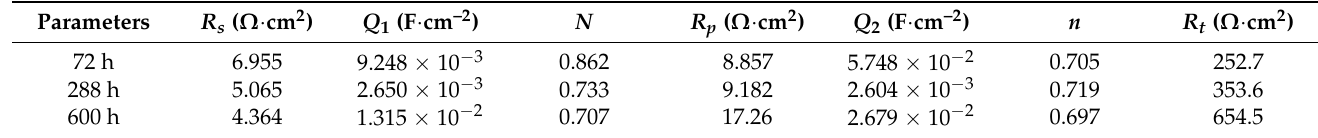
Table 3. Fitting parameters of EIS shown in Figure 11 by the equivalent circuit in Figure 12.